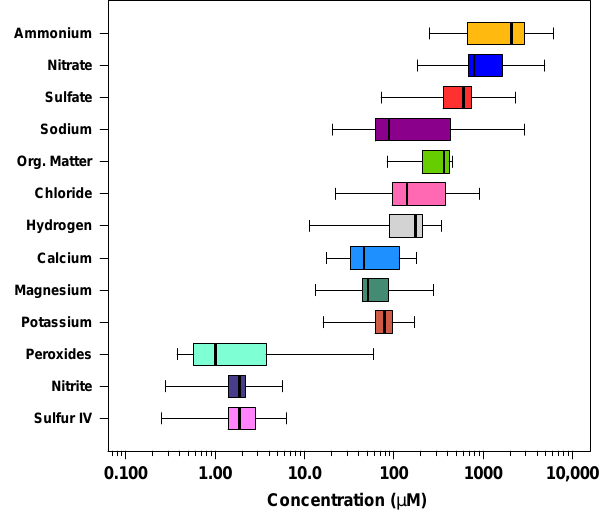
Figure 3. Concentrations of major components quantified in BYI fog samples. Boxes show 25th and 75th percentiles with the median bar in the center, and whiskers show outliers. Total organic mat- ter was calculated from measured TOC using a ratio of 1.8 g/1.0 g OM/OC (Zhang et al., 2005) and an estimated mean molecular mass of 100 gmol − 1 . Note that for most ions, n = 13; for pH, S(IV), and peroxides, n = 11; for formaldehyde, n = 10; and for total organic matter, n =